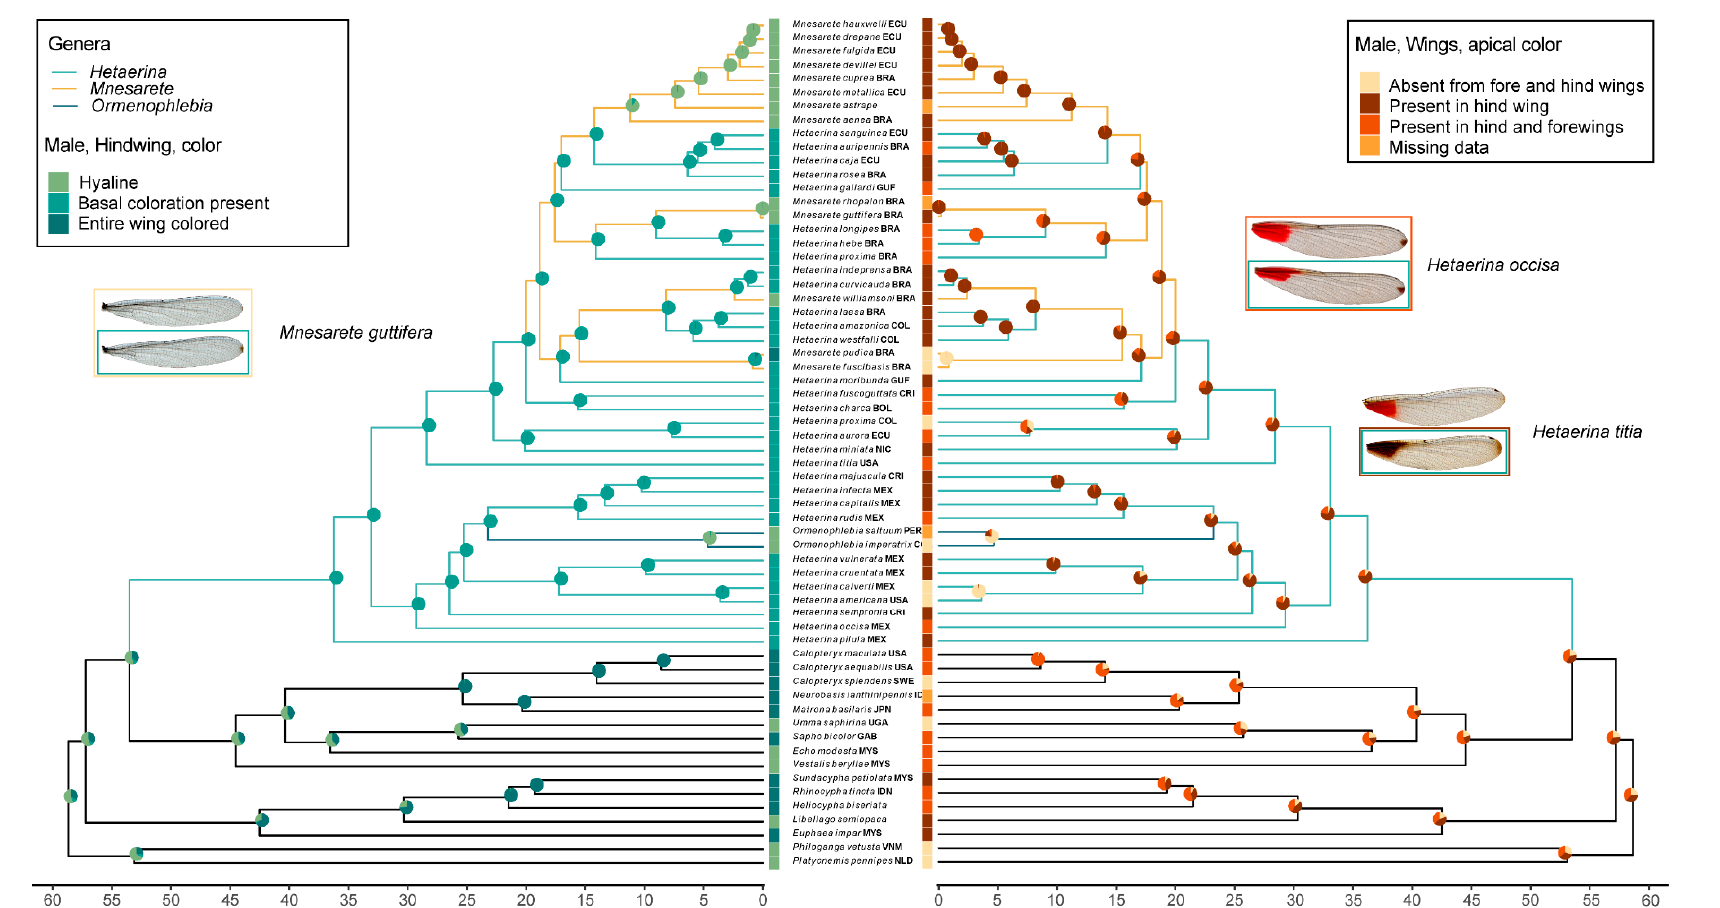
Figure 4. Likelihood ancestral character state reconstruction of coloration in male wings. Characters mapped onto divergence dated phylogeny generated in BEAST2. Pie charts show probability of presence or absence of state at each node. Left: ACSR of male hindwing color mapped onto phylogeny. Green: Hyaline wings. Teal: Basal coloration present. Dark blue: Entire wing colored. Basal coloration has the highest likelihood for the ancestral node of Hetaerininae. Right: ACSR of apical color in male wings mapped onto phylogeny. Tan: Apical color absent from forewings and hindwings. Dark red: Apical color present in hindwing. Red: Apical color present in hindwings and forewings. Orange: Missing data. Wings for three species shown, forewing on top, hindwing on bottom: Mnesarete guttifera , Hetaerina occisa and Hetaerina titia . Colored boxes show character state.